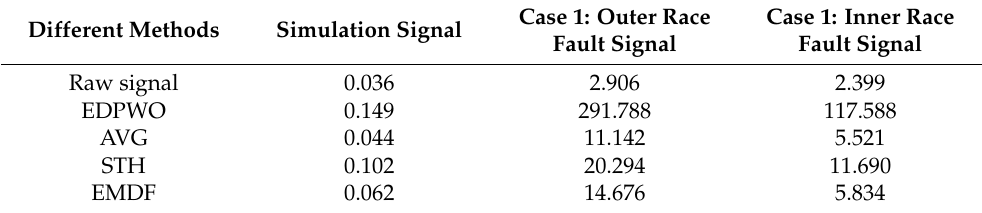
Table 8. Quantitative comparison of kurtosis and CPU time of different methods.